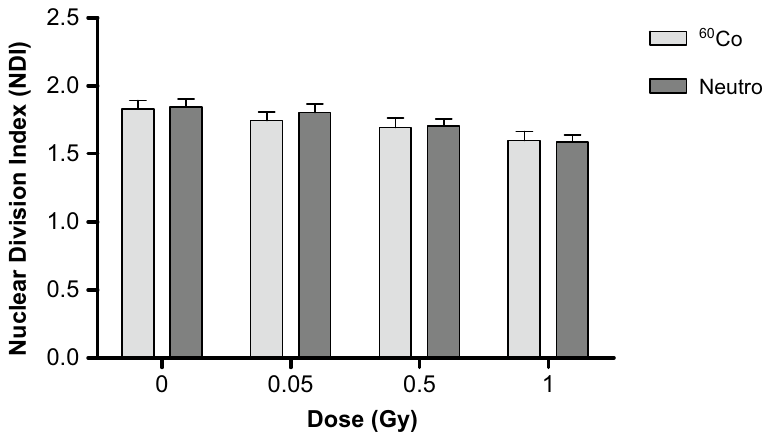
Figure 3. The nuclear division index (NDI) was calculated to compare the proliferation status of the micro- culture CBMN assay for the CD34 + samples irradiated with different radiation qualities with doses of 0, 0.05, 0.5 and 1 Gy. Error bars represent the standard error of the mean (SEM) of the 12 different donors for each radiation quality. At least 500 viable cells were manually scored for each donor per condition.